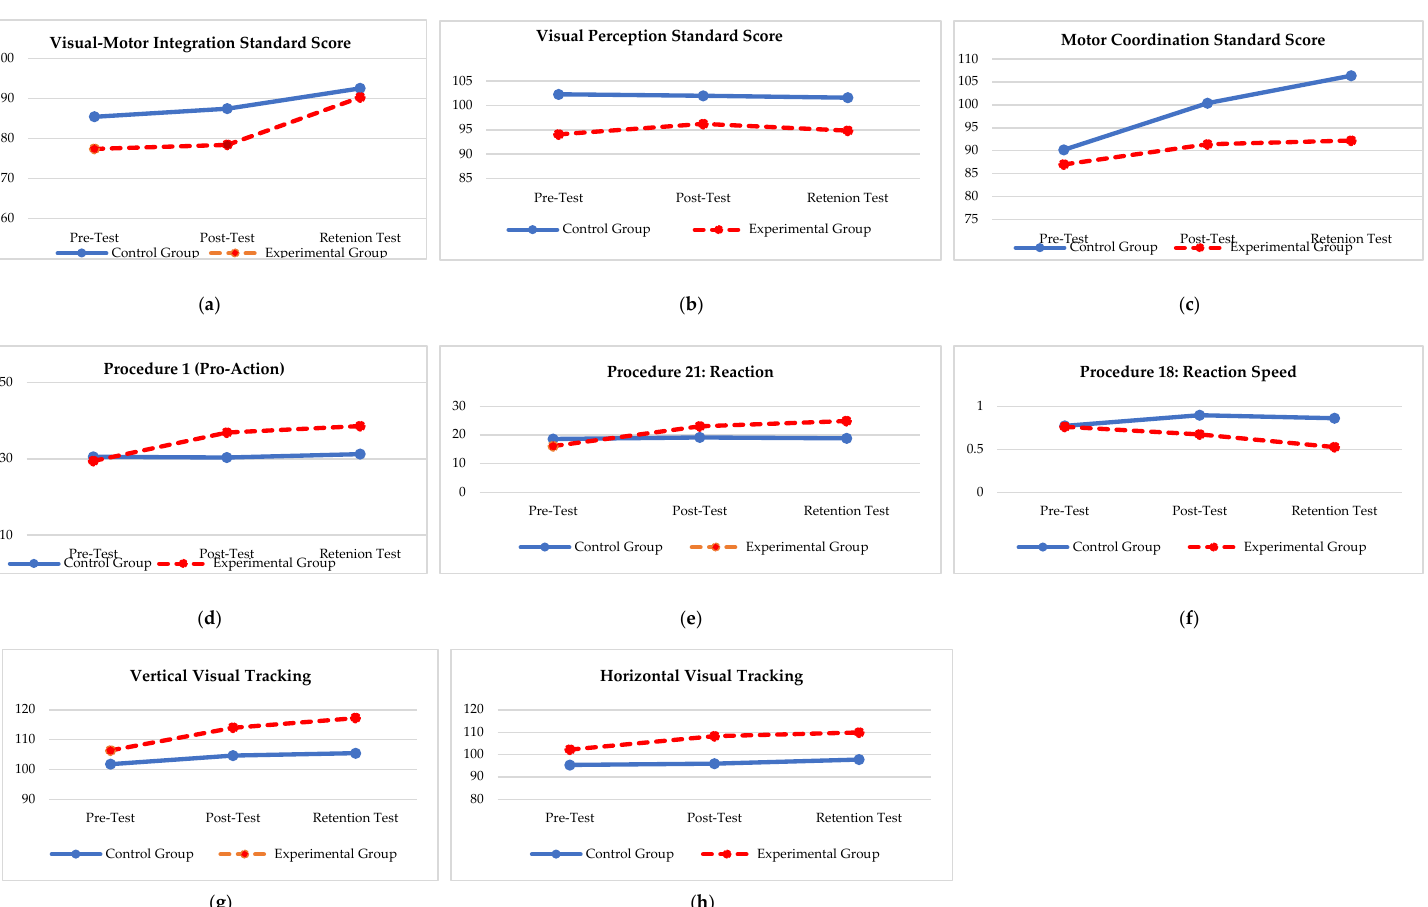
Figure 2. Group interaction over time regarding the Beery Visual–Motor Integration (VMI-4) test, Wayne Saccadic Fixator (WSF) and Developmental Eye Movement (DEM) test. ( a ) Group × Time effect for during pre-; post- and retention test (f = 3.33; p = 0.082). ( b ) Group × Time effect during pre-; post- and retention test (f = 1.58; p = 0.222). ( c ) Group × Time effect during pre-; post- and retention test (f = 5.18; p = 0.033). ( d ) Group × Time effect during pre-; post- and retention test (f = 12.34; p = 0.002). ( e ) Group × Time effect during pre-; post- and retention test (f = 3.69; p = 0.068). ( f ) Group × Time effect during pre-; post- and retention test (f = 26.02; p ≤ 0.001). ( g ) Group × Time effect during pre-; post- and retention test (f = 1.62; p = 0.217). ( h ) Group × Time effect during pre-; post- and retention test (f = 1.26; p = 0.275).